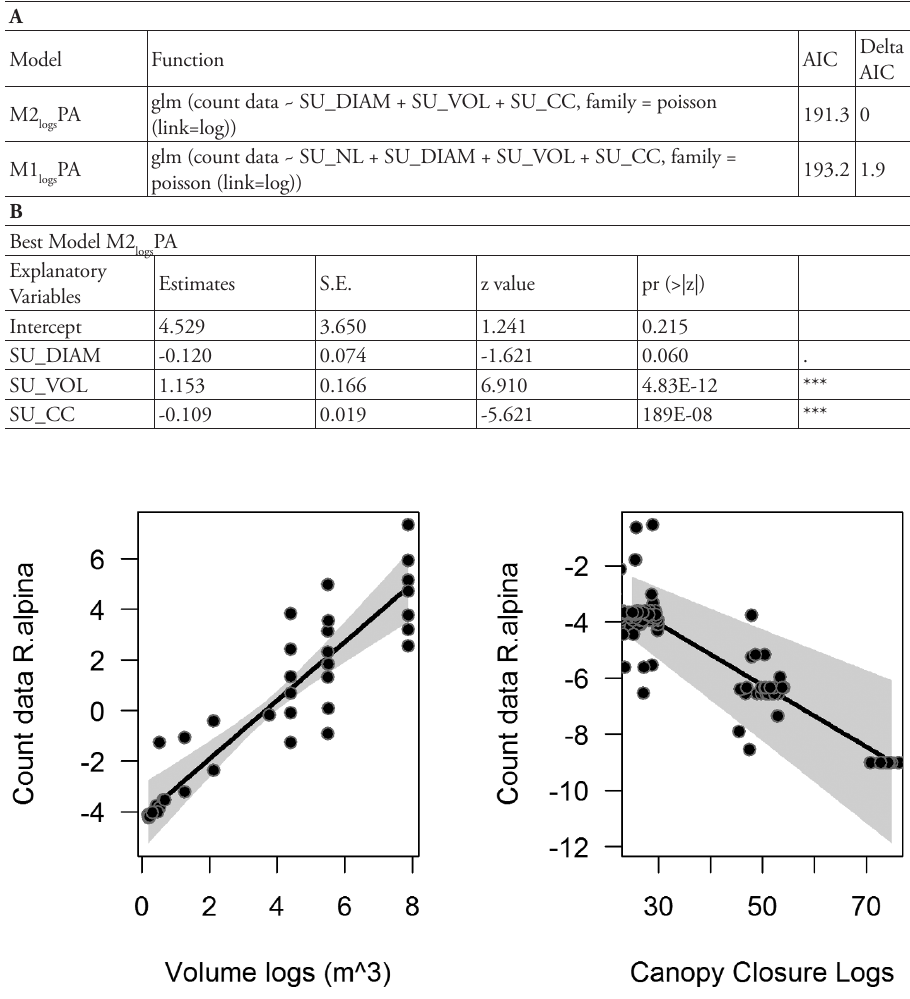
Table 8. Generalised Linear Models results. A) Explanatory variables selection and final best model for count data of R. alpina on logs in PA. For each model are reported the function used to build the model, AIC value and Delta AIC for selecting the best model, B) Estimates and standard error (S.E.) of the two explanatory variables of the best model; significant codes: 0 ‘***’, 0.001 ‘**’, 0.01‘*’, 0.05 ‘.’.